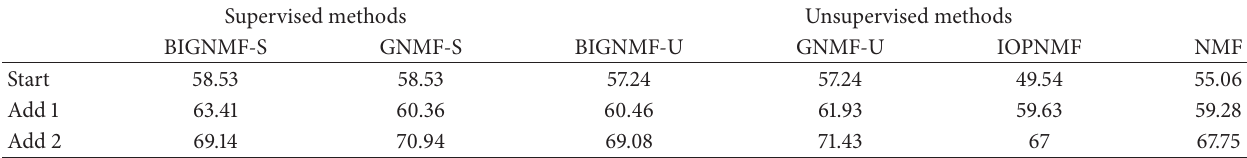
Table 3: The recognition rates (%) for the FERET database during adding 2 batches of images belonging to different classes. Supervised methods